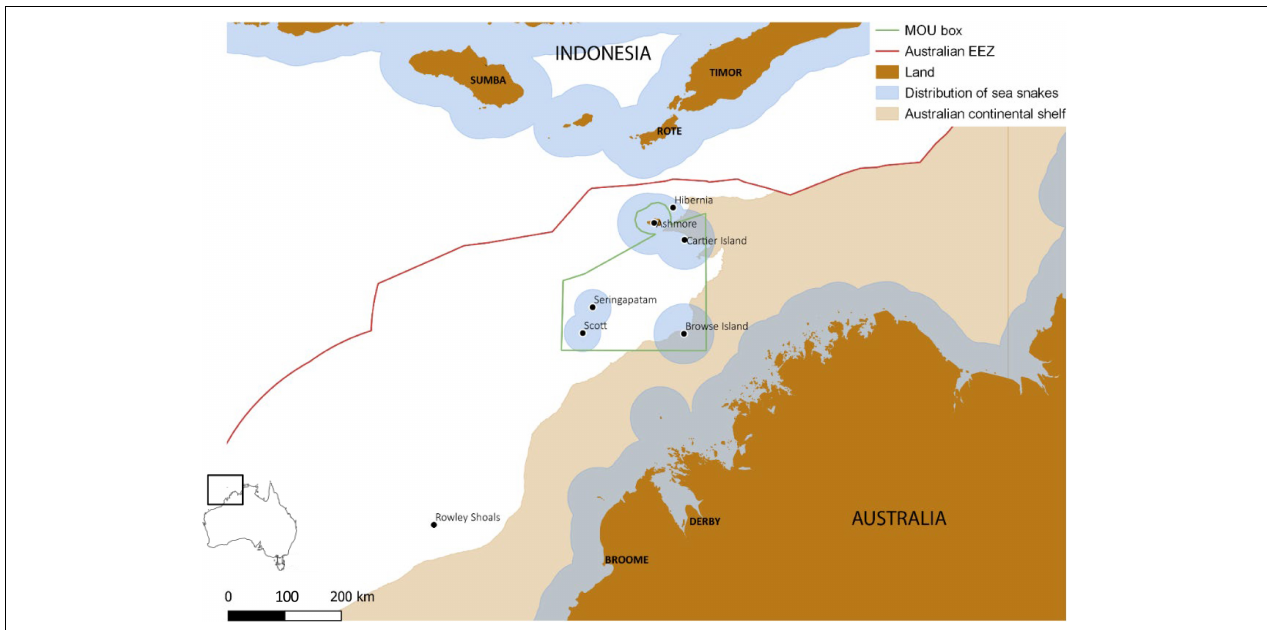
FIGURE 1 | Location of Ashmore Reef in relation to other reefs and islands in the Timor sea, and administrative boundaries including the Memorandum Of Understanding (MOU) Box (ATNS, 2004), Australian Exclusive Economic Zone (EEZ), Indonesia and Australia. Estimated potential distribution of benthic-foraging sea snakes is based on habitat preferences and presence records generated by the IUCN sea snakes specialists’ group for the IUCN Red List of Threatened Species (downloaded on 1 October